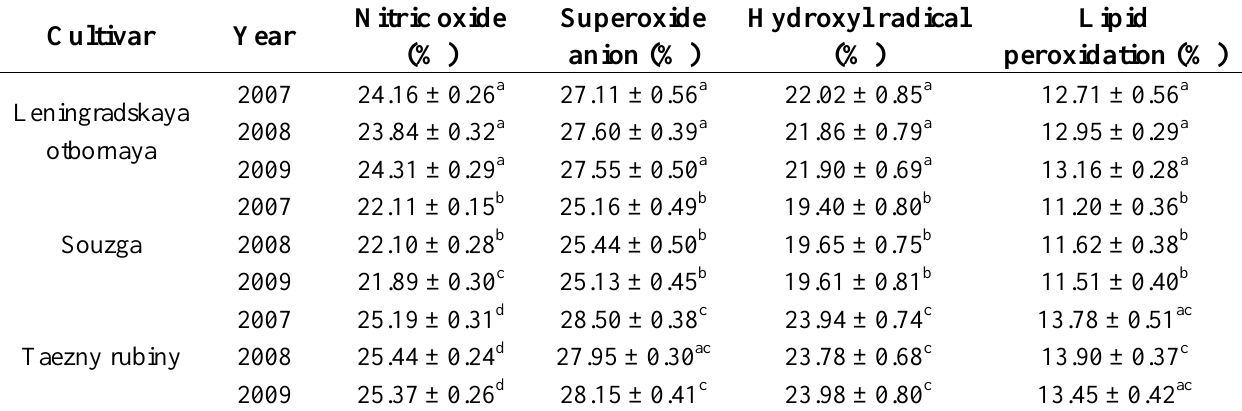
Different superscripts in each column indicate the significant differences in the mean at P < 0.05.